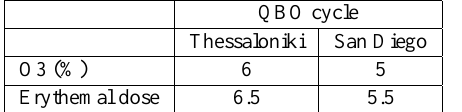
Table 2. Peak-to-peak amplitudes for the QBO cycles of ozone and erythemal dose at Thessaloniki and San Diego, from TOMS observations, during the period 1978-1993 (seven QBO cycles) QBO